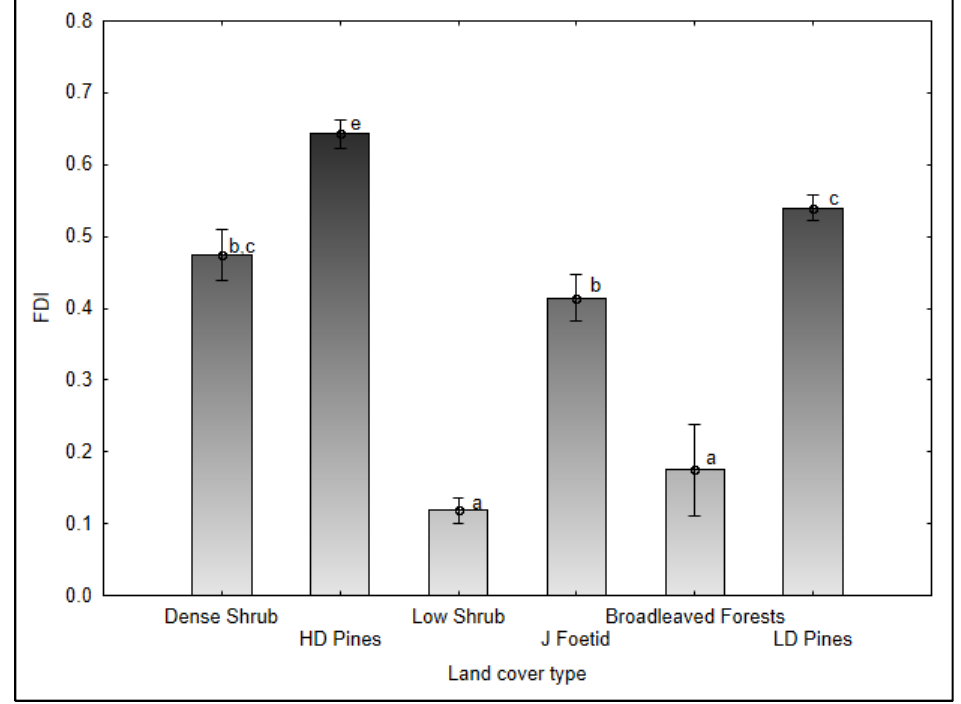
Figure 7. FDI mean for the burnable landcover classes in the study area. Different letters indicate statistically significant differences. Vertical bars denote ± one standard error.